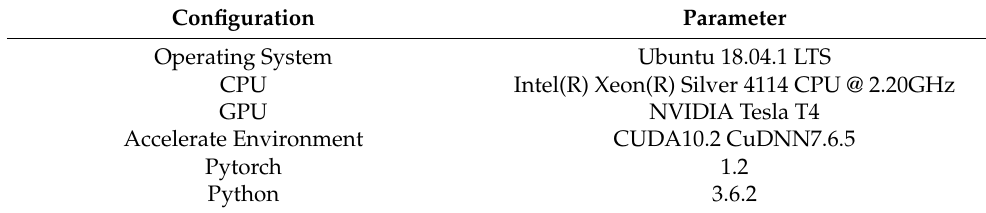
Table 2. Training and test environment configuration table.